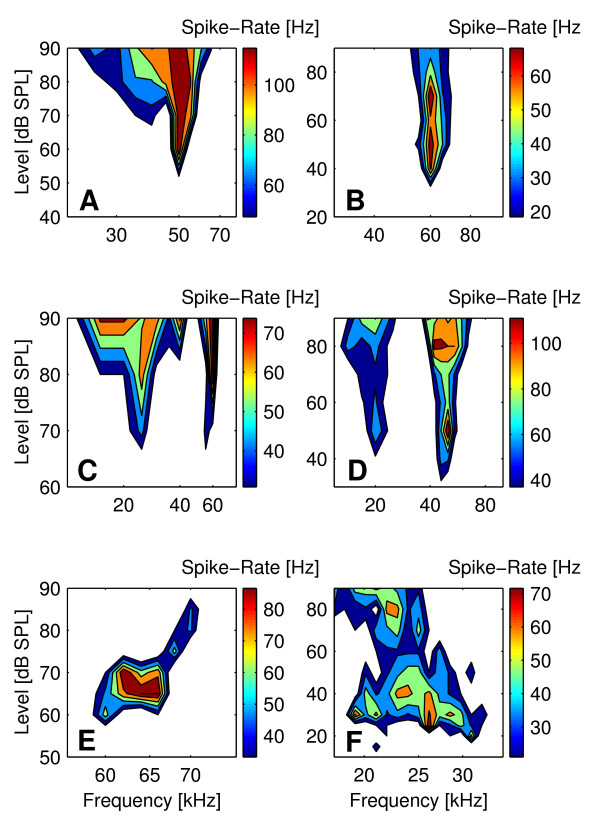
Examples of the six different FRA types of cortical units. Examples of the different classes of FRA types are shown for: A) monotonically V-shaped, B) non-monotonically V-shaped, C) monotonically double tuned, D) non-monotonically double tuned, E) circumscribed and F) complex FRAs.